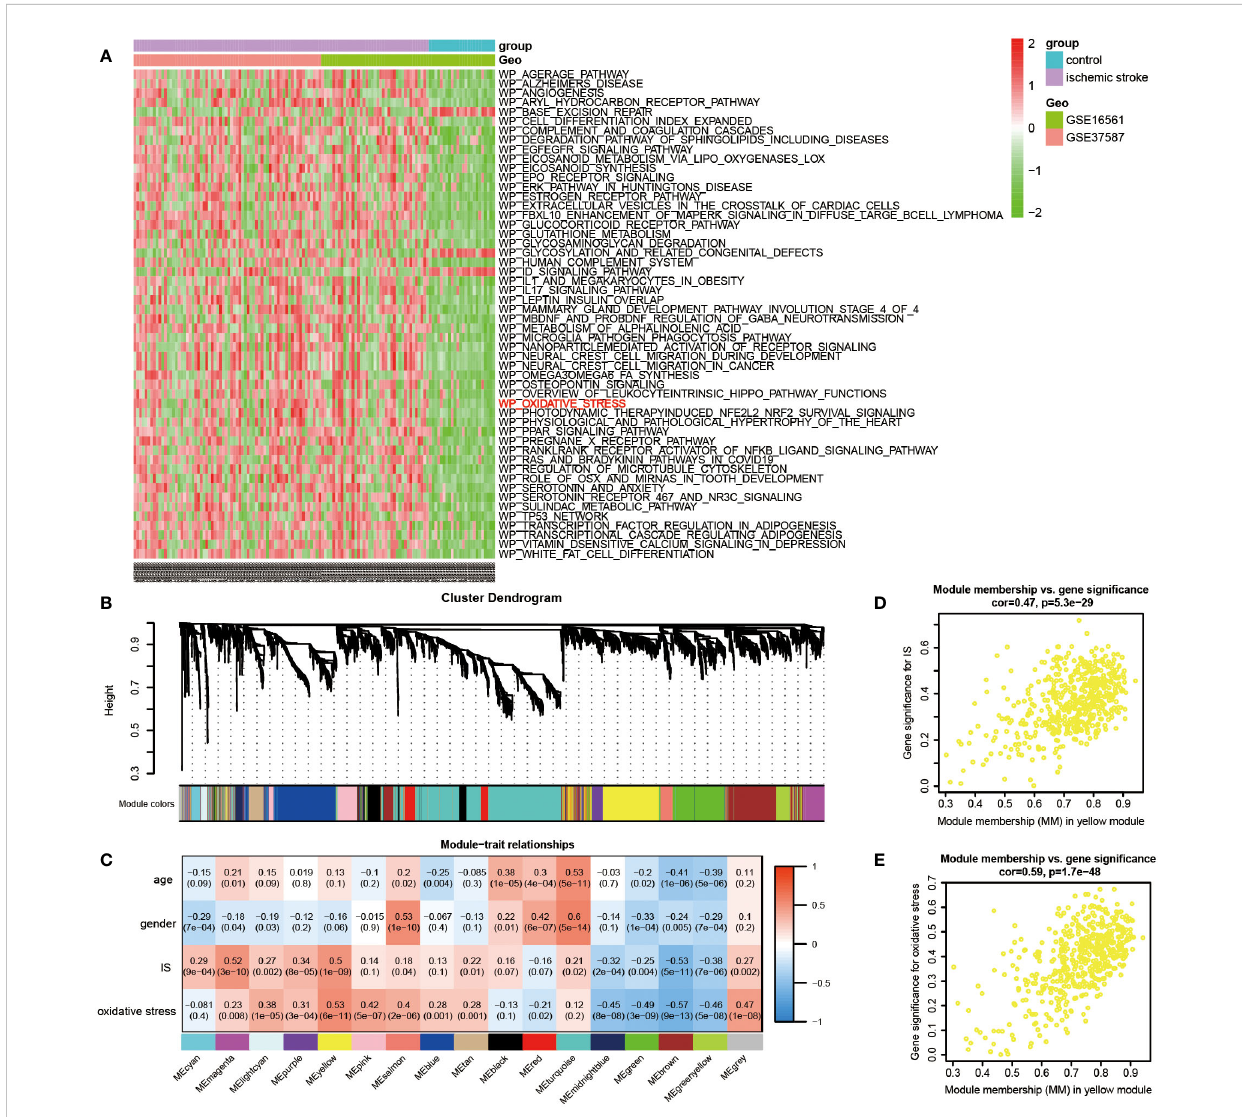
FIGURE 2 Identi fi cation of IS-speci fi c oxidative stress-related genes (ISOSGS). (A) Heatmap of differential pathways showing signi fi cantly up-regulated oxidative stress pathway in early IS. (B) Cluster dendrogram of 17 gene modules. (C) The heatmap of module-trait relationships. (D) Scatter diagrams of module membership vs . gene signi fi cance for IS in yellow module; (E) Scatter diagrams of module membership vs . gene signi fi cance for oxidative stress state in yellow